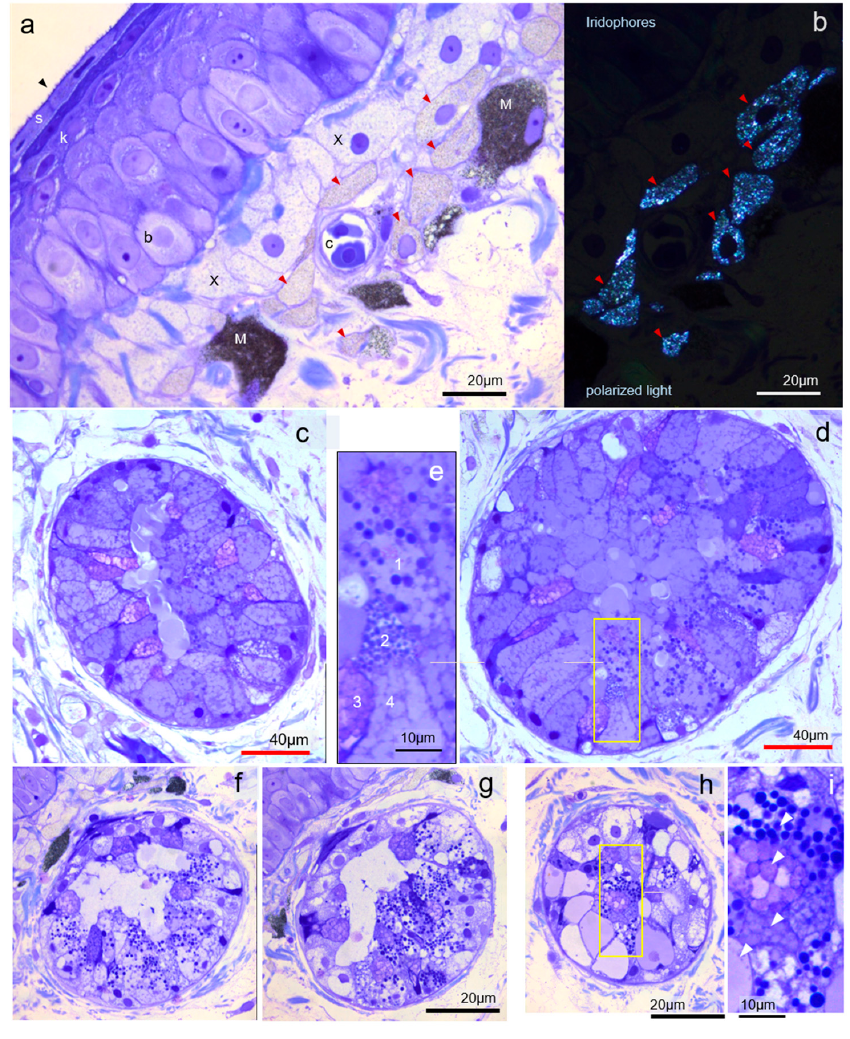
Figure 3. Semi-thin sections of tegument epithelium and mucous glands. Toluidine-blue stained. Surface epithelium and pigmentary layers architecture ( a ); iridophores ( b ) of the previous section (arrowheads) under polarised light. Common ( c ) and large ( d ) mucous glands and morphology of the secretory granules ( e ). Near-adjacent sections ( f,g ) of the smaller glands show patchy clonal